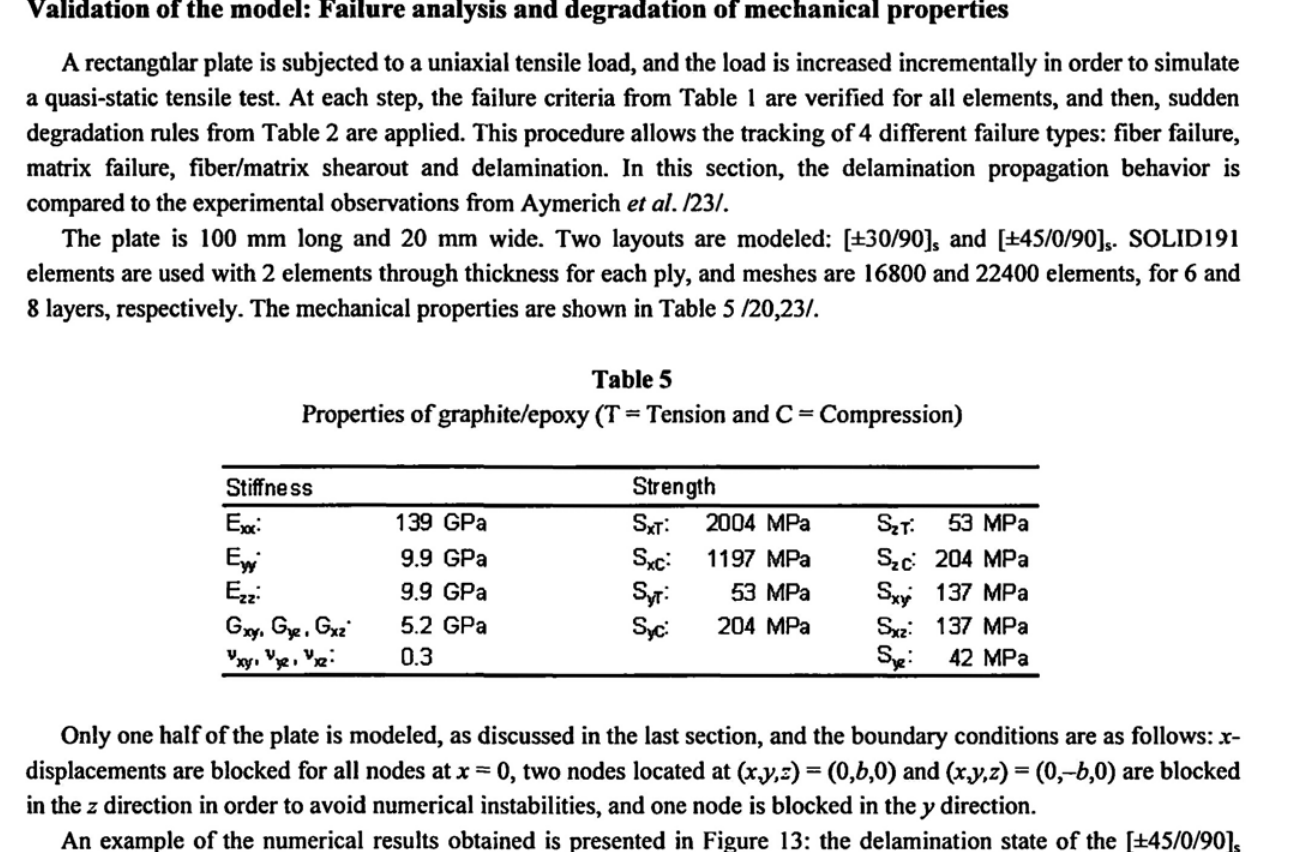
Properties of graphite/epoxy (T = Tension and C = Compression)